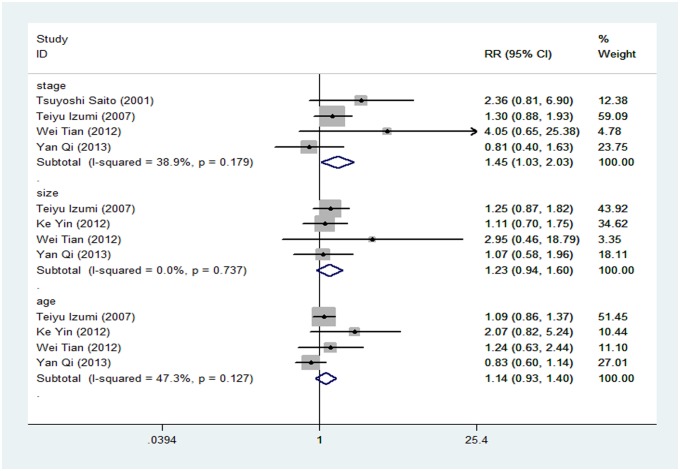
Risk ratios (RRs) and 95% confidence intervals (CIs) in studies assessing the relationship between E-cadherin negative expression and the higher stage (III–IV).(RR: 1.446, 95% CI: 1.030–2.028, P = 0.033); large tumor (>5cm) (RR: 1.226, 95% CI: 0.941–1.597, P = 0.130); and old age (>20 year-old) (RR: 1.138, 95% CI: 0.927–1.398, P = 0.216).